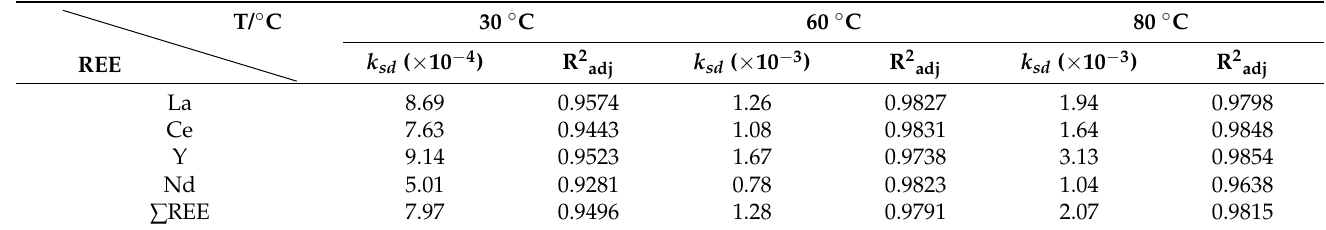
Table 4. k sd and R 2 adj for the SCM of diffusion control based on spherical particles.